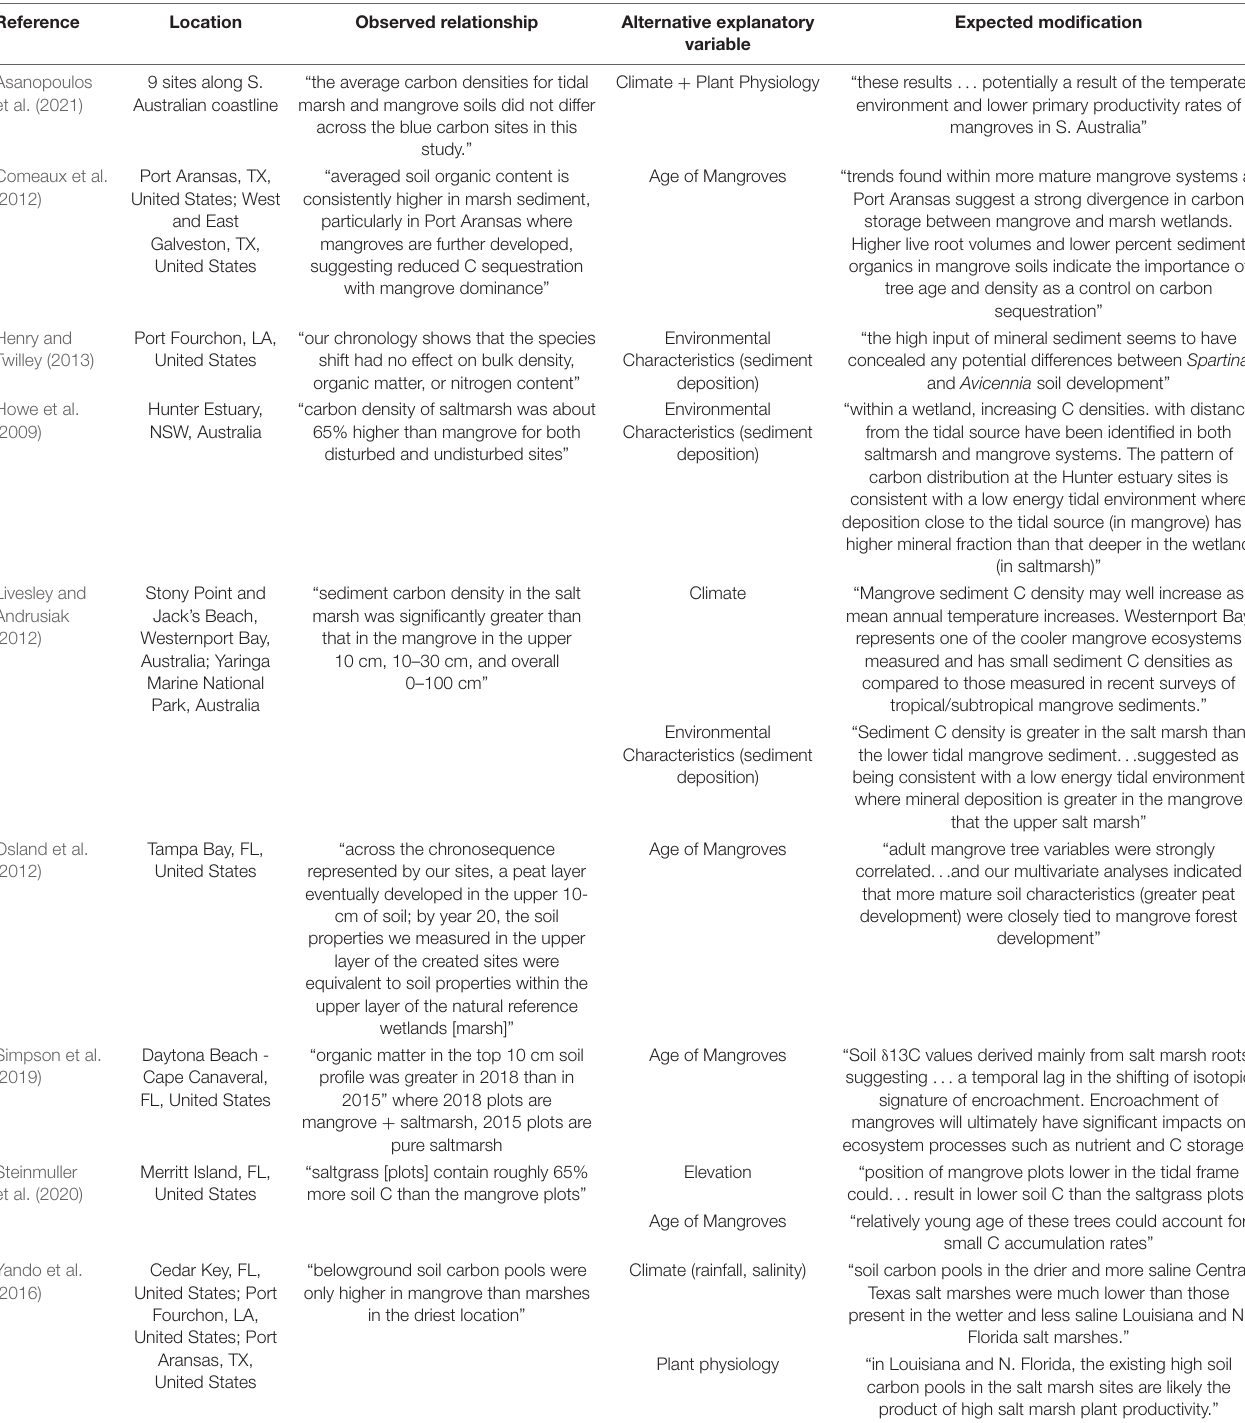
TABLE 4 | Studies with published C density relationships between mangroves and tidal marshes along encroachment fronts with quotes that explain (A) the observations between the two dominant plant taxa, and (B) expectations of how alternative explanatory variables might modify that